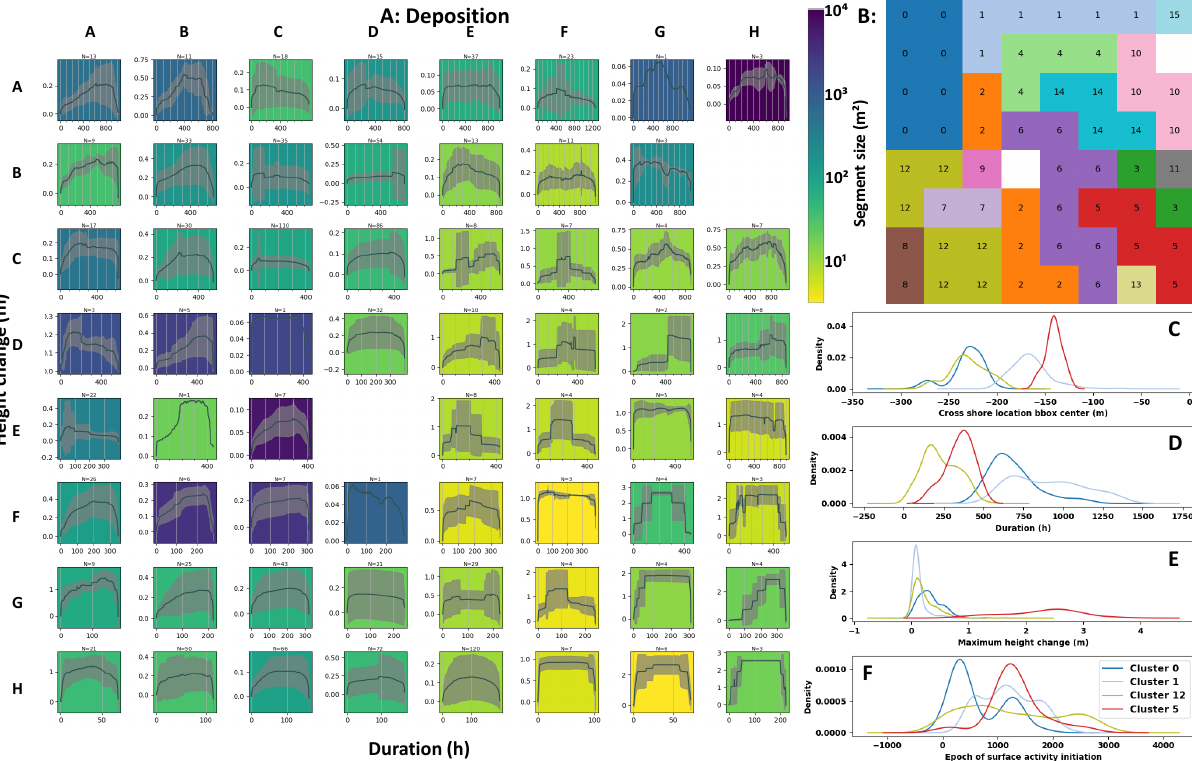
Figure 5. A) Visualization of the deposition Self-organizing Map (i.e., SOM D). For detailed explanation refer to the caption of Figure 4. B) The clusters found with a distance threshold of 230. Each grid point refers to a node in A, each color and number represents one cluster of nodes. C-F) Density plots of four features of the 4D objects-by-change grouped in cluster 0, 1, 5 and